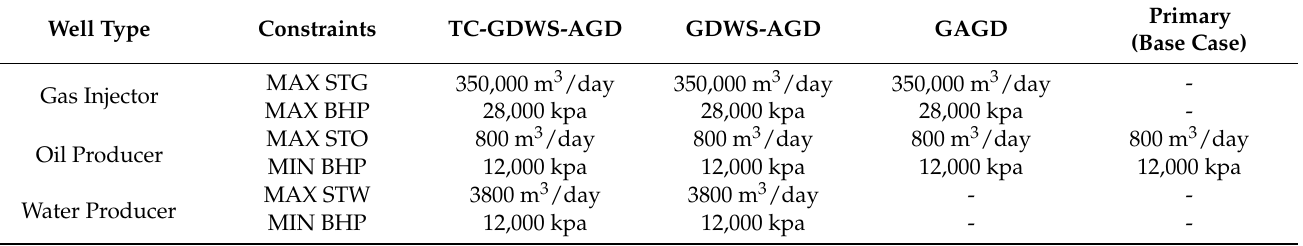
Table 2. Well-related constraints applied to the TC-GDWS-AGD, GDWS-AGD, and GAGD EOR cases and the primary base production case for the PUNQ-S3 simulations